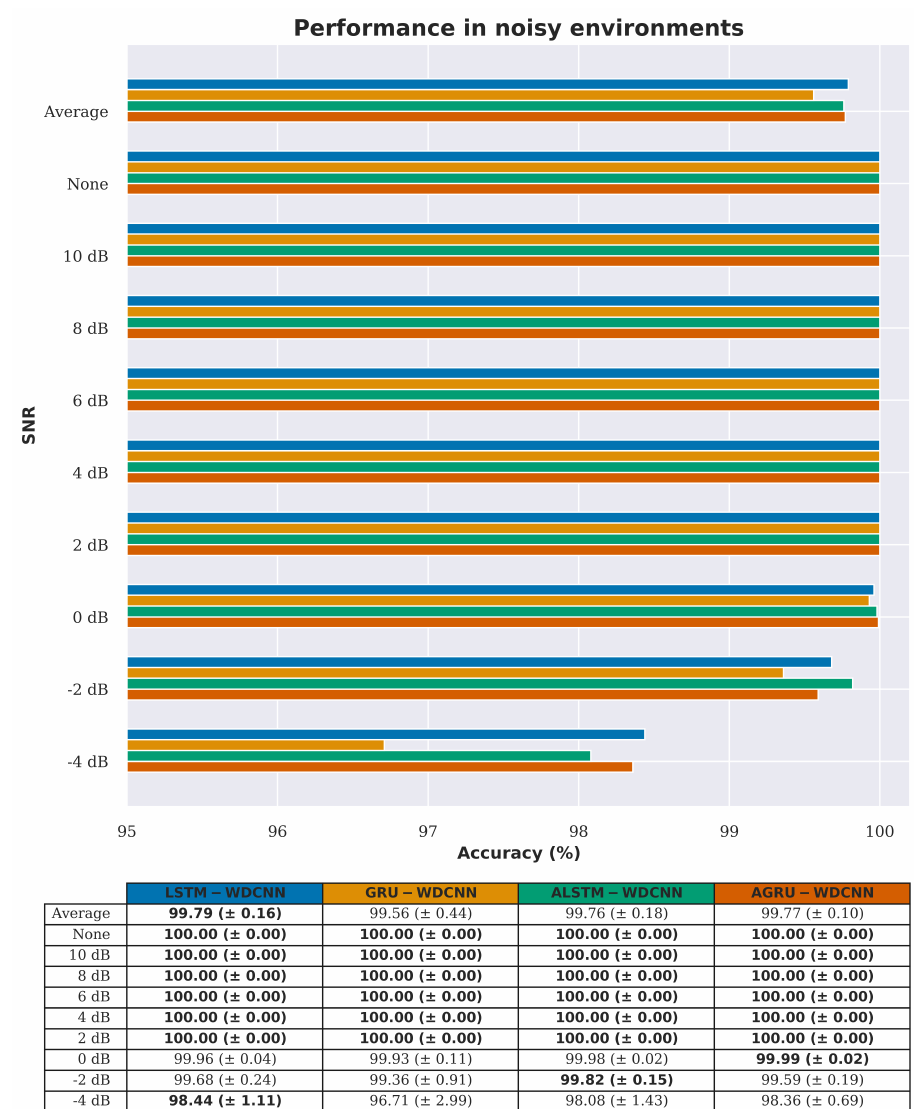
Figure 12. Noise rejection accuracy comparison between the different recurrent pathways in RNN-WDCNN (best values are highlighted in